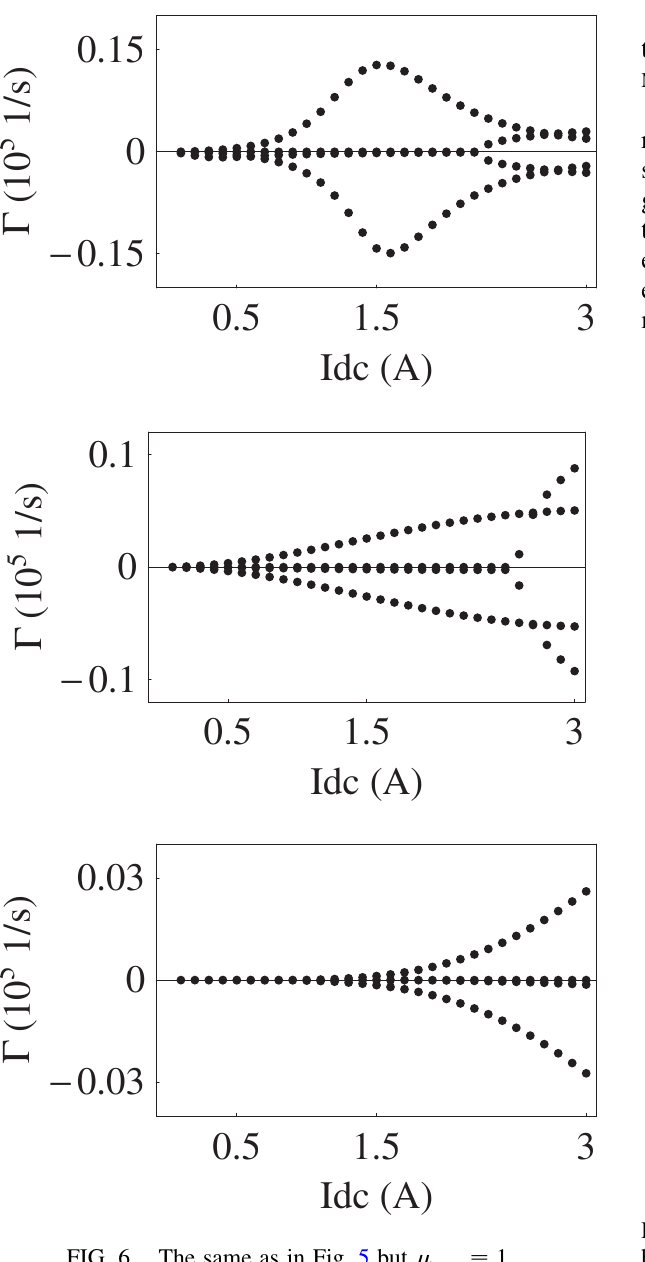
FIG. 6. The same as in Fig. 5 but (cid:5)